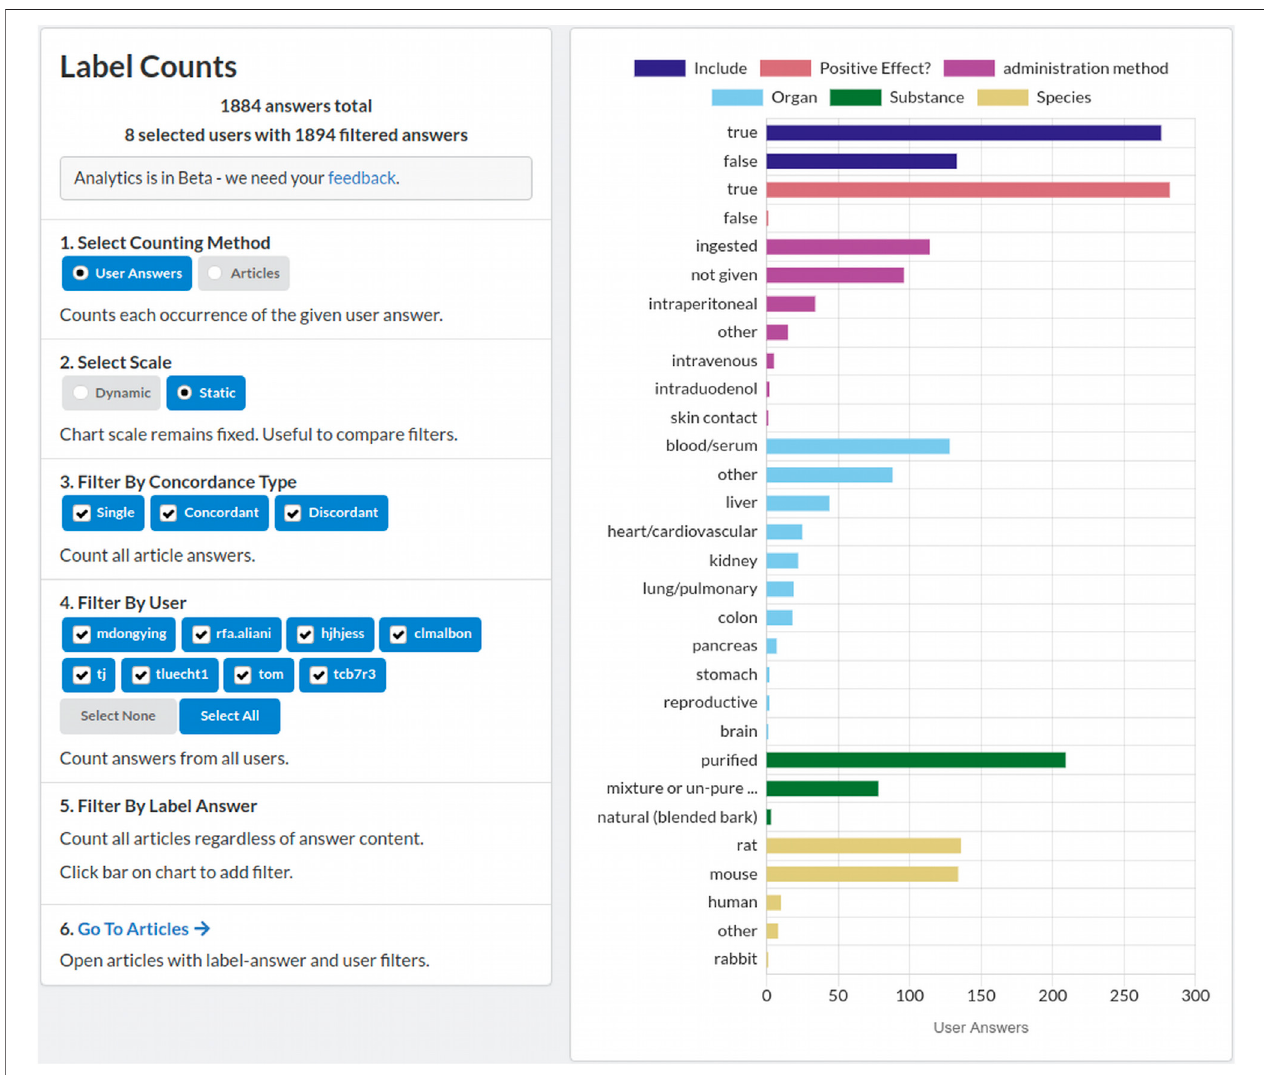
FIGURE 3 | A screenshot of the sysrev label counting tool. A demonstration of this tool is publicly available at https://sysrev.com/o/2/p/21696/analytics/labels. Label counts can be fi ltered, visualized and updated in real time as a sysrev progresses.